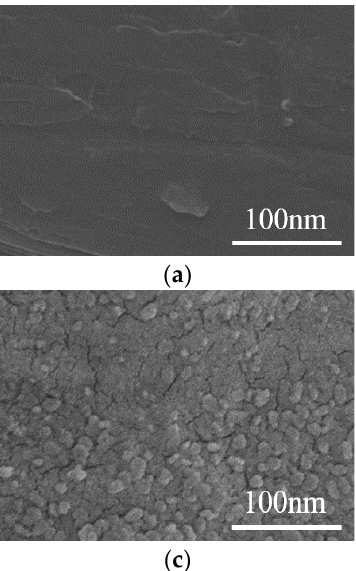
Figure 3. Scanning electron microscopy (SEM) test results (scale bar: 100 nm) before and after the modification of aramid insulation paper ( a ) F0 Sample SEM; ( b ) F1 Sample SEM; ( c ) F2 Sample SEM; ( d ) F3 Sample SEM.